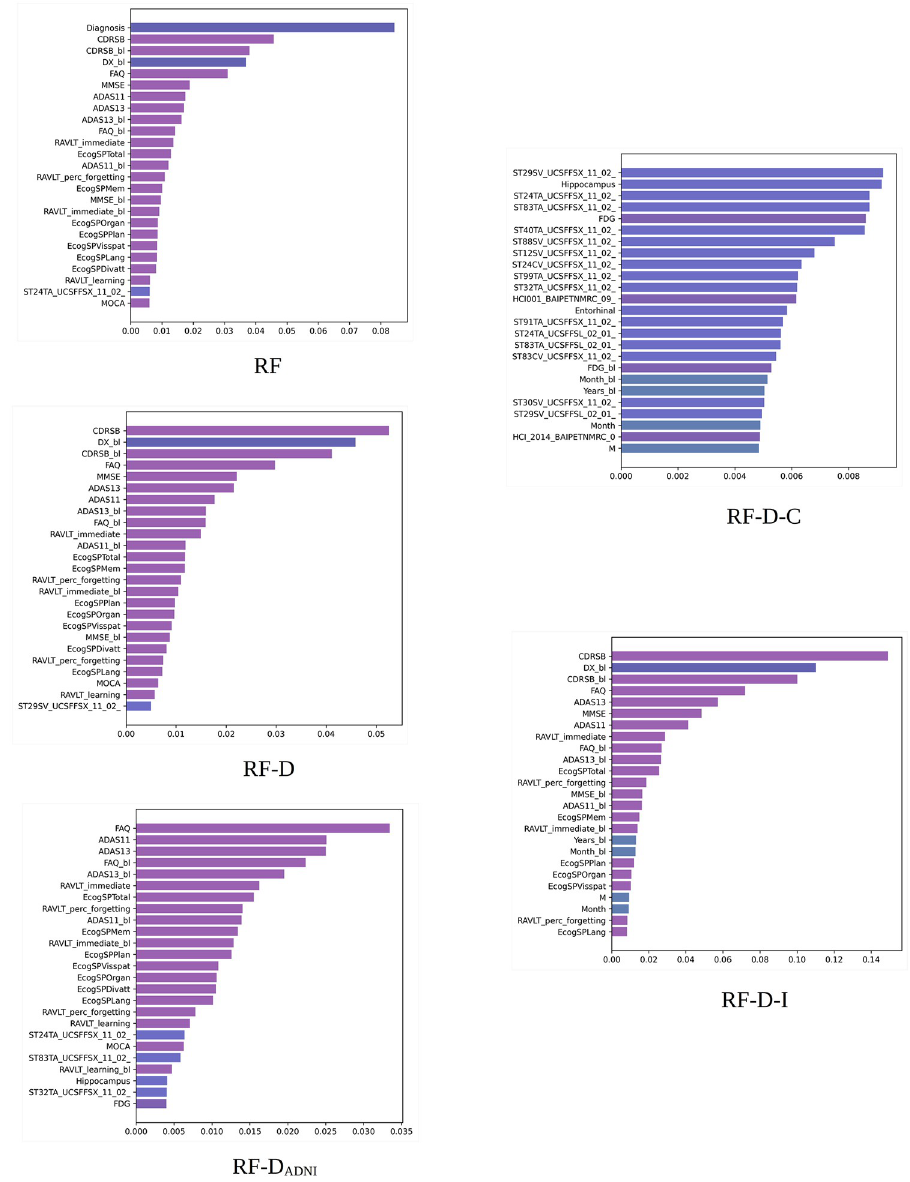
Fig 3. RF built-in importance. Importance scores obtained by different RF models. Scores averaged over 10 random experiments for the 100% training set. Long feature names have been trimmed for better legibility. The bars are colored by feature type (diagnosis, clinical, cognitive, MRI, PET, DTI, APOE4, and proteomic